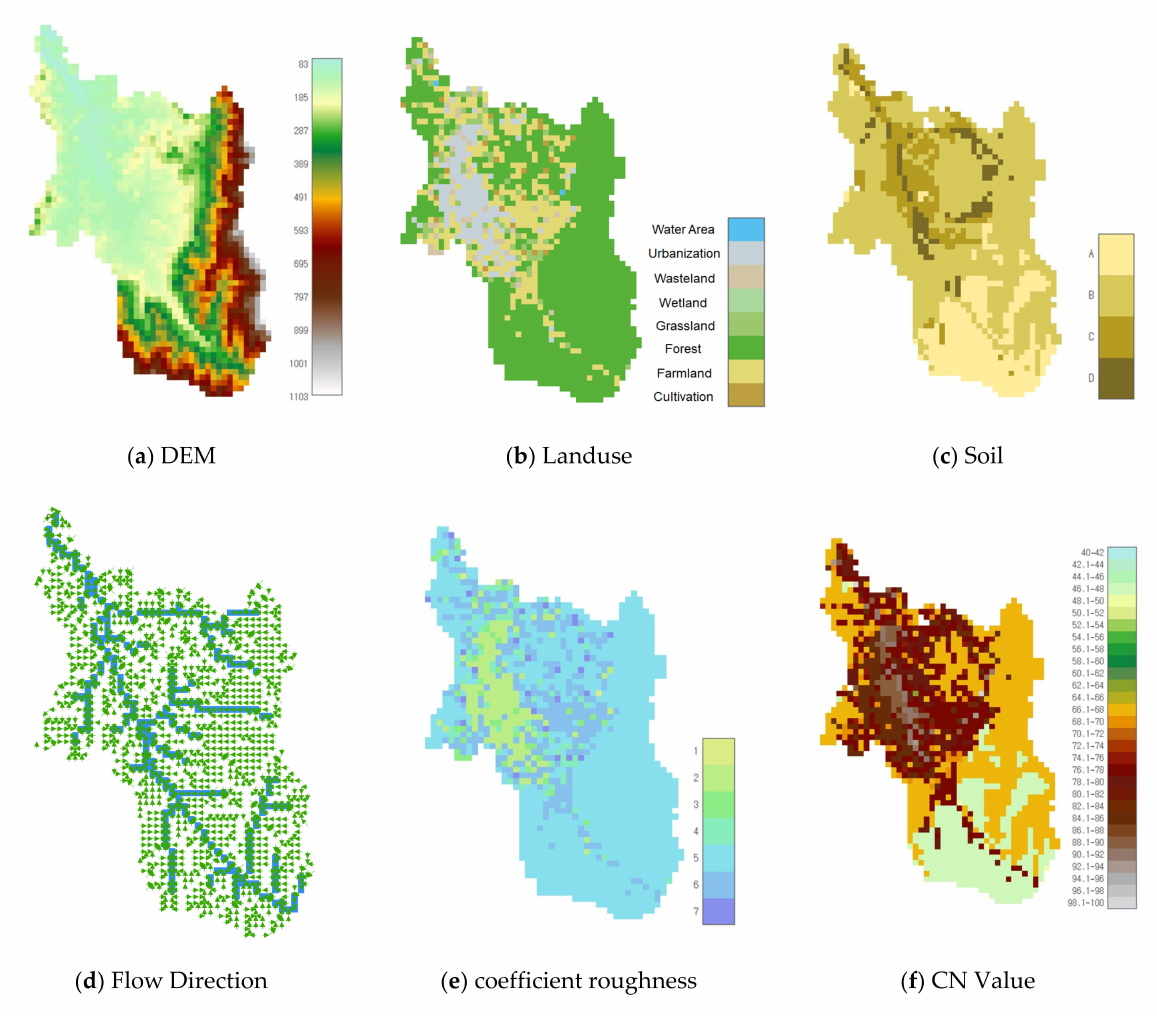
Figure 11. Input Data of S-RAT Model.